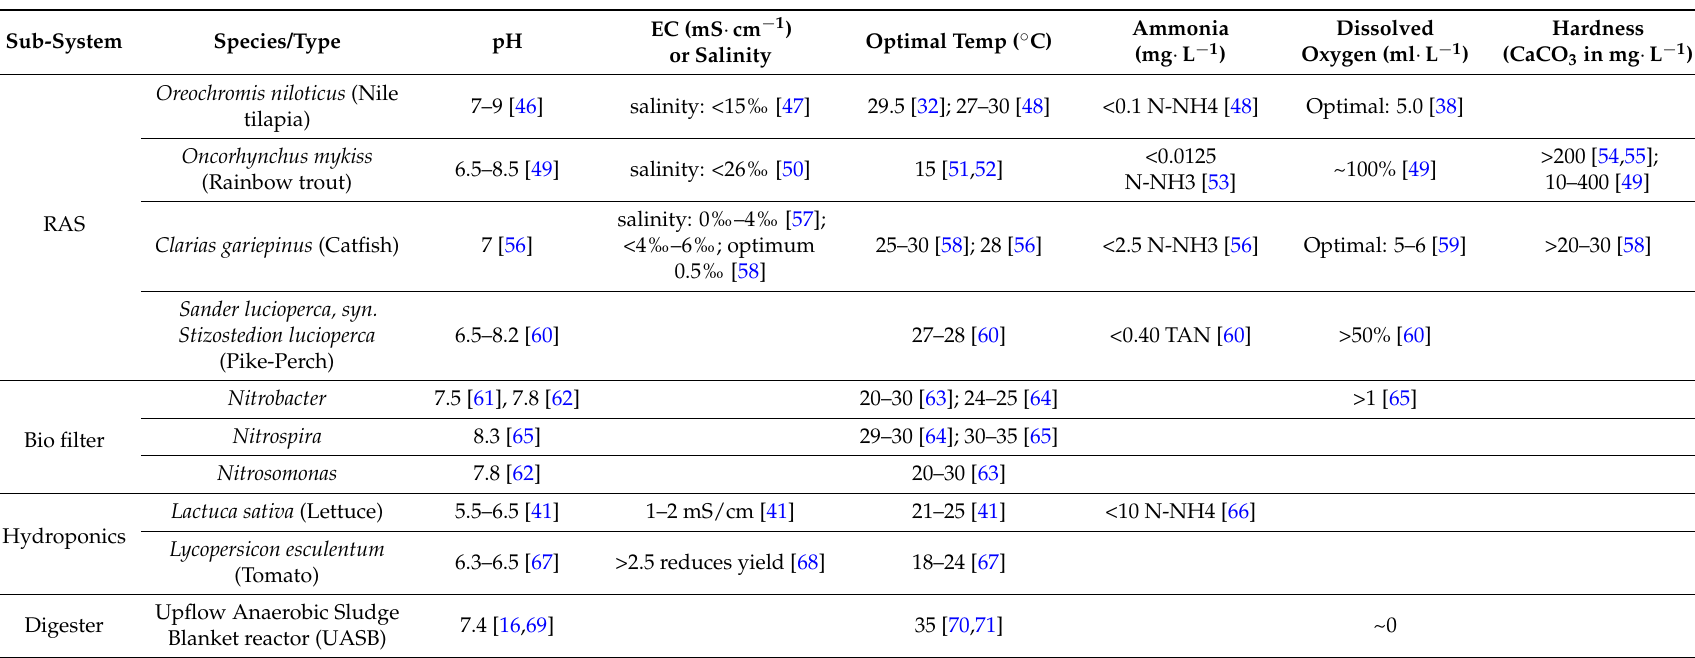
Table 3. Optimal conditions for different fish in RAS (i.e., tilapia, European perch and rainbow trout), plant species in hydroponic conditions (i.e., lettuce and tomato), biofiltration efficiency being a part of RAS, and anaerobic digestion.